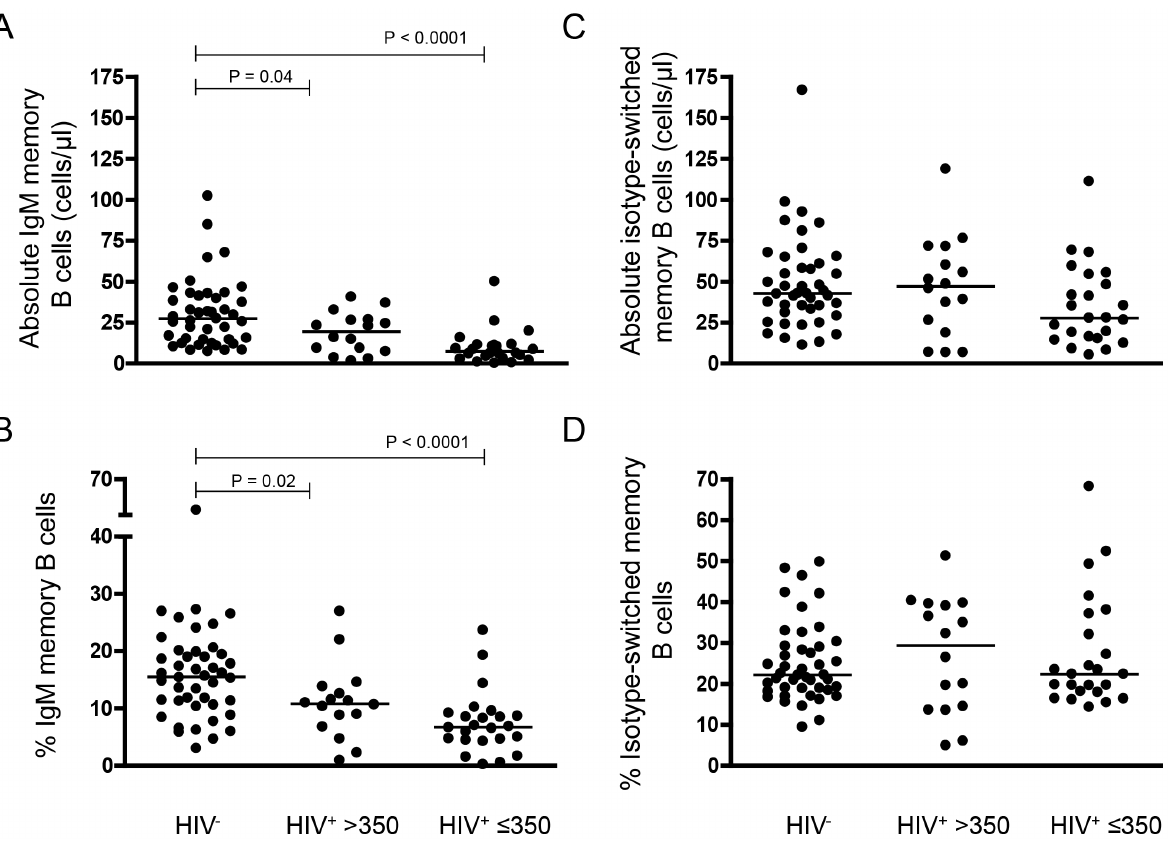
Figure 2. IgM memory B-cells are depleted while isotype-switched memory B-cells are maintained in HIV-infected Malawian adults. (A) IgM memory B-cells (CD19 + CD27 + IgD + ) absolute numbers, (B) percentages and (C) isotype-switched memory B-cell (CD19 + CD27 + IgD 2 ) numbers, (D) percentages in the circulation of HIV 2 controls (n=44), HIV + . 350 (n=16) and HIV + # 350 (n=24) adult. Horizontal bars represent medium values. Statistical significance of differences between groups was assessed using the Mann Whitney U test.